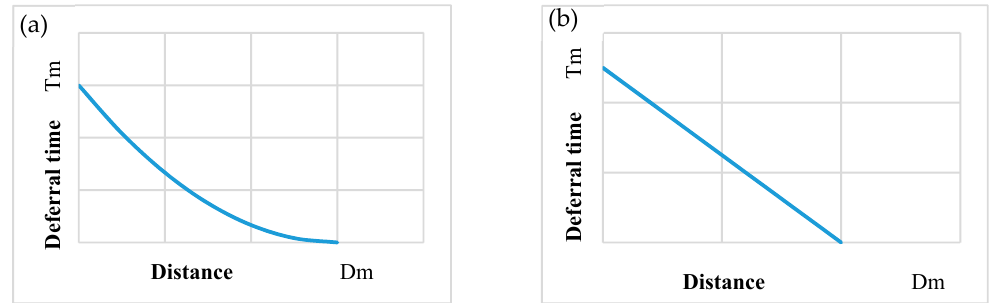
Figure 3. Exponential and linear deferral time. ( a ) Exponential decreasing deferral time; ( b ) linear decreasing deferral time.